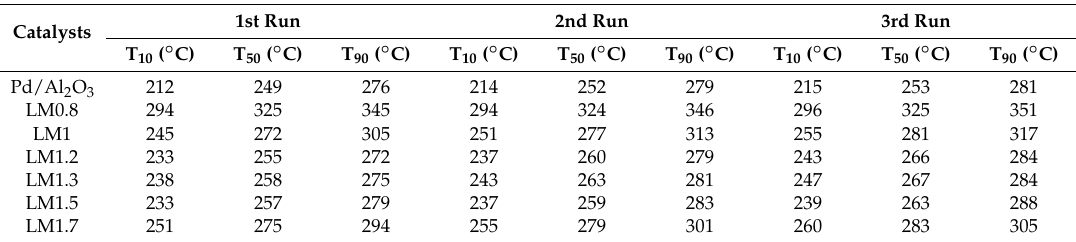
ions (La 3+ + Mn 2+ ) for selected LM catalysts.